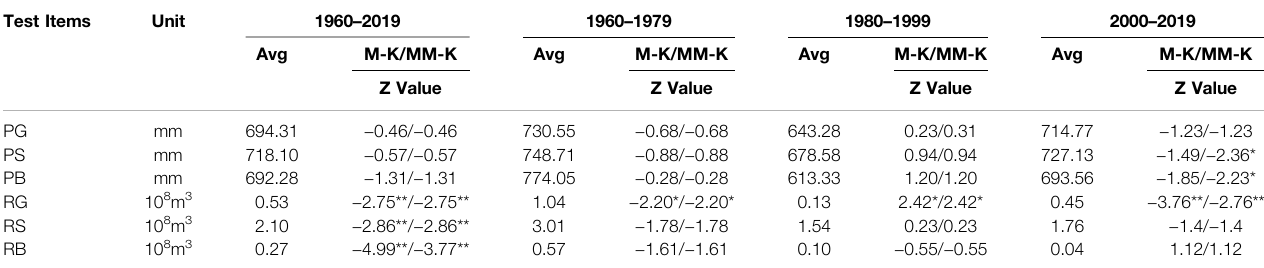
TABLE 4 | Trend analysis for the precipitation and runoff series observed at the hydrological stations (G: GR, S: SR, B: BR, P: Precipitation, R: Runoff). Test